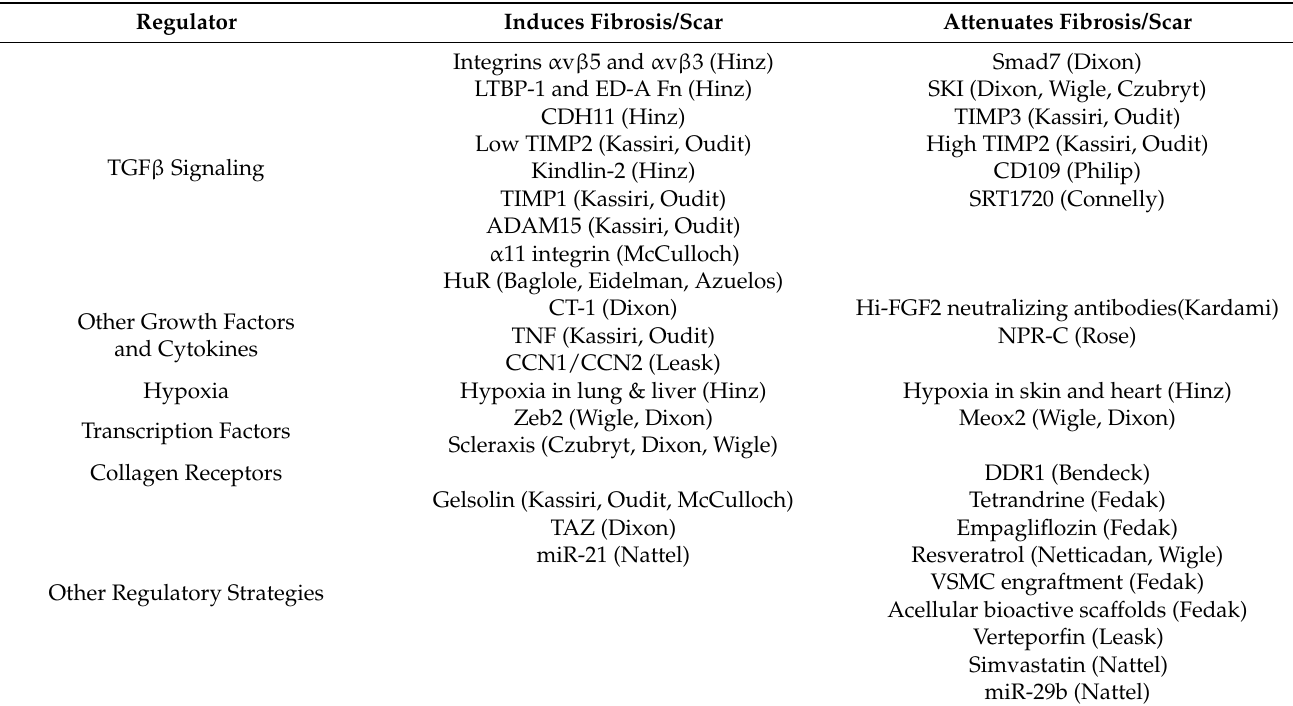
Table 1. Canadian contributions to understanding fibroblast biology and fibrosis. Effects of various regulators are divided into that those that promote fibrosis and/or scarring, and those that are inhibitory. Laboratory leaders and key collaborators are